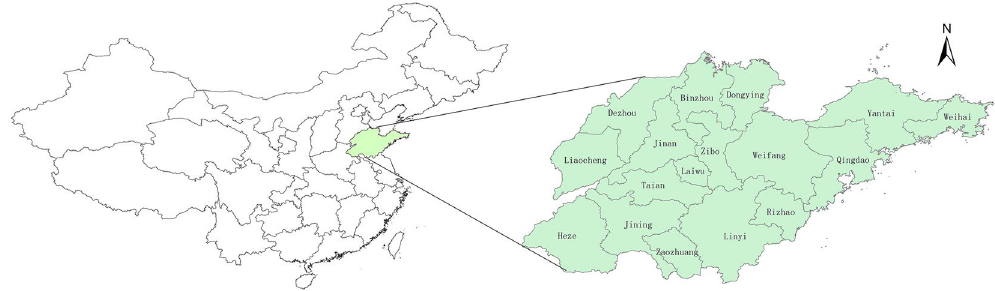
Figure 1. Location of Shandong Province, China (ArcGis 10.2 http://www.esri.com/software/arcgis/